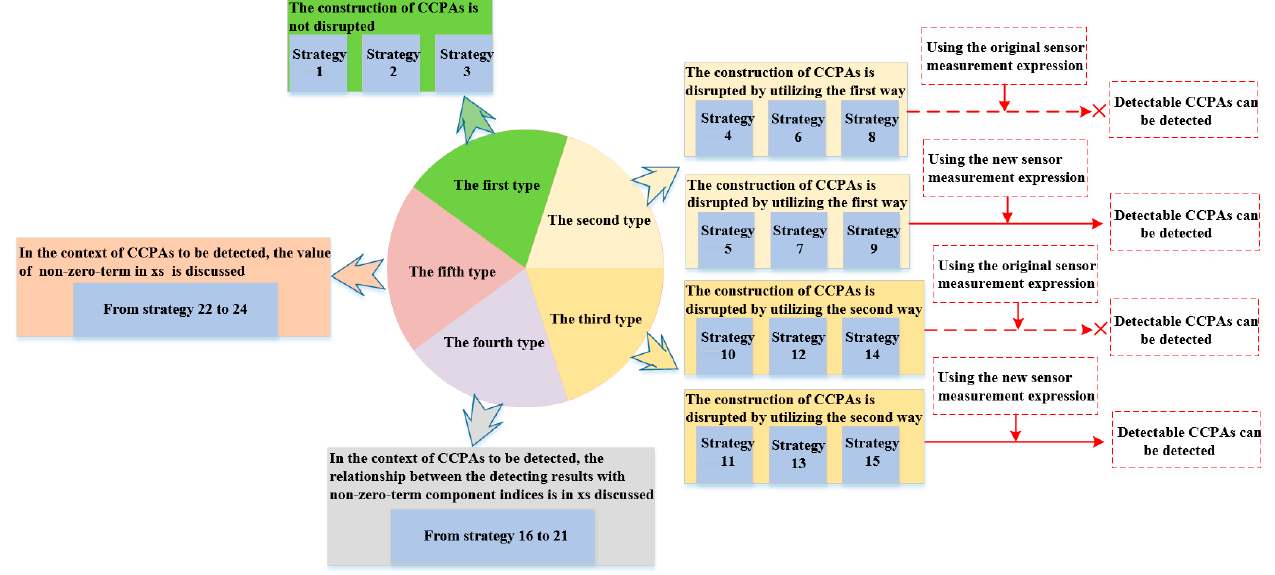
Figure 5. The overall block diagram of the proposed simulation